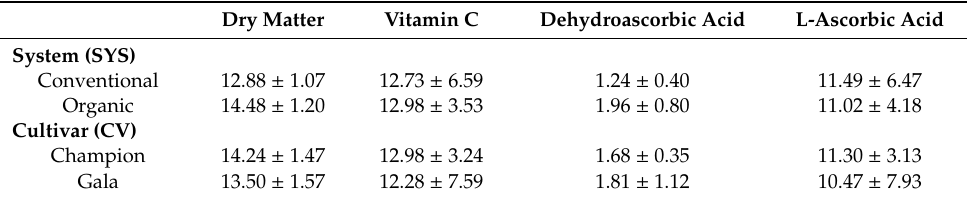
Table 1. The main e ff ect of (and interaction between) the production system (conventional and organic), cultivar (Champion, Gala, Idared) and harvest year (2017, 2018) on the dry matter content (g / 100 g f.w.) and vitamin C (mg / 100 g f.w.) concentrations (mean ± SD) in apple